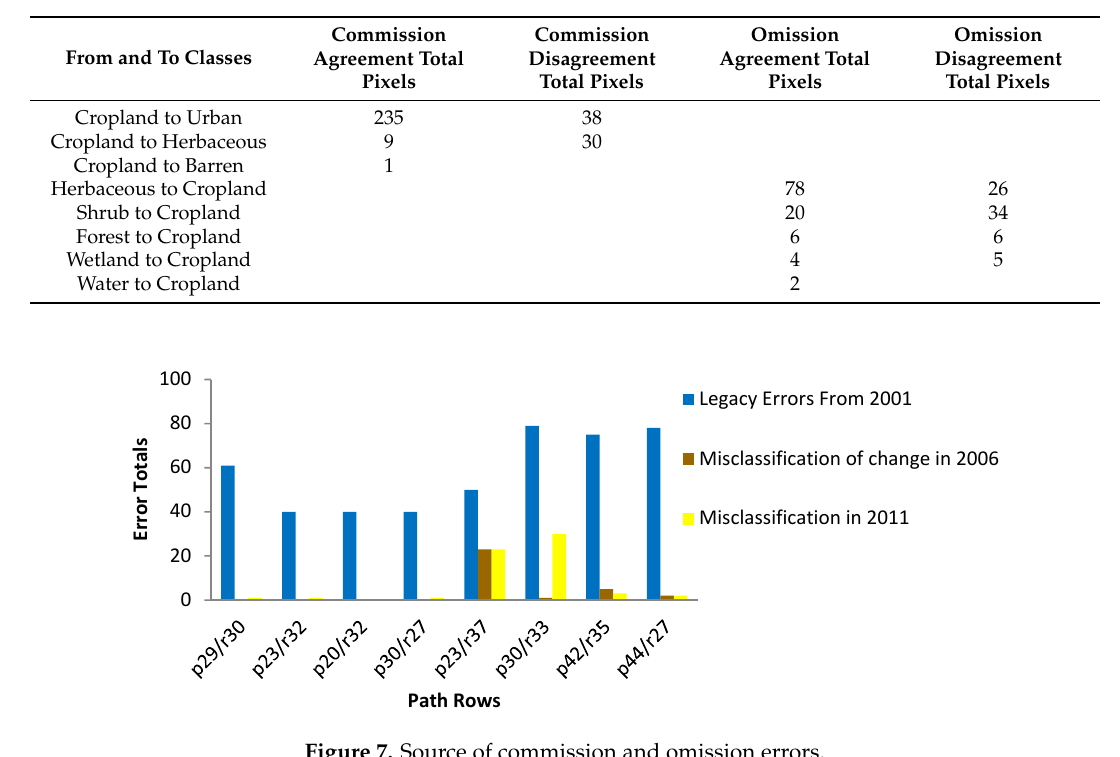
Table 3. Commission and Omission Agreement/Disagreement From and To Classes.